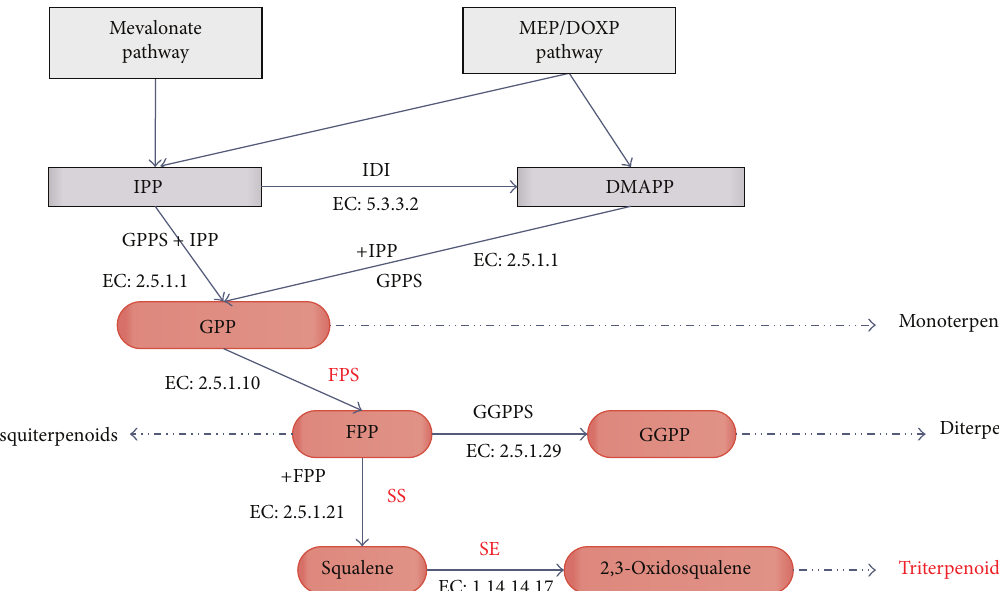
Figure 4: FPS, SS, and SE in the synthesis pathway of triterpenoids. Note: IPP: isopentenyl-PP; IDI: isopentenyl-diphosphate delta- isomerase; DMAPP: dimethylallyl-PP; GPS: geranyl-diphosphate synthase; GPPS: geranylgeranyl diphosphate synthase; GPP: geranylgeranyl diphosphate; FPS: farnesyl diphosphate synthase; GGPPS: geranylgeranyl diphosphate synthase; GGPP: geranylgeranyl diphosphate; SS: squalene synthase; and SE: squalene epoxidase.